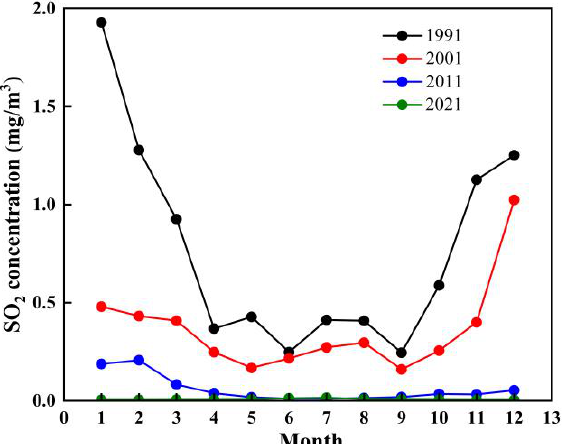
Figure 1. Average daily variations of indoor (Cave 9) and outdoor air temperature and RH in the Yungang Grottoes during 2017.